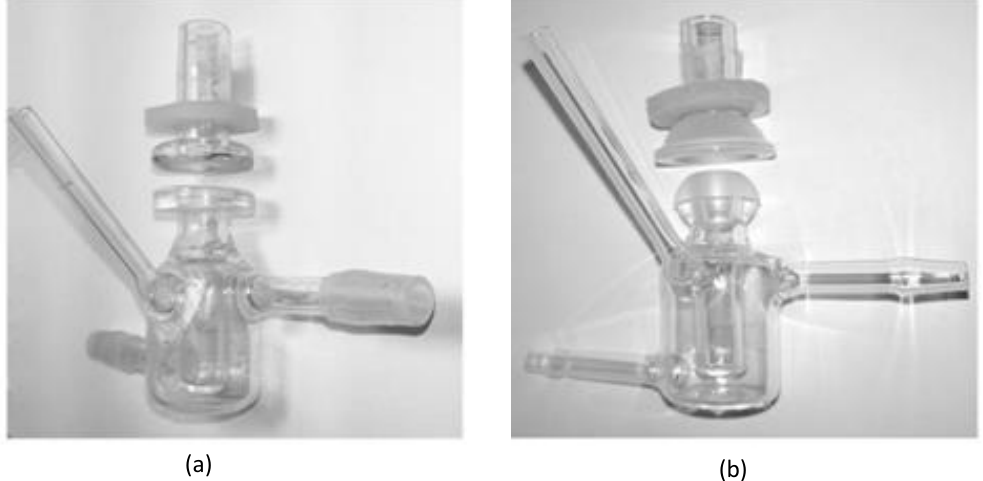
Figure 2. Franz diffusion cell set up for diffusion studies: ( a ) flat-mouth Franz diffusion cell, ( b ) arc- mouth Franz diffusion cell.